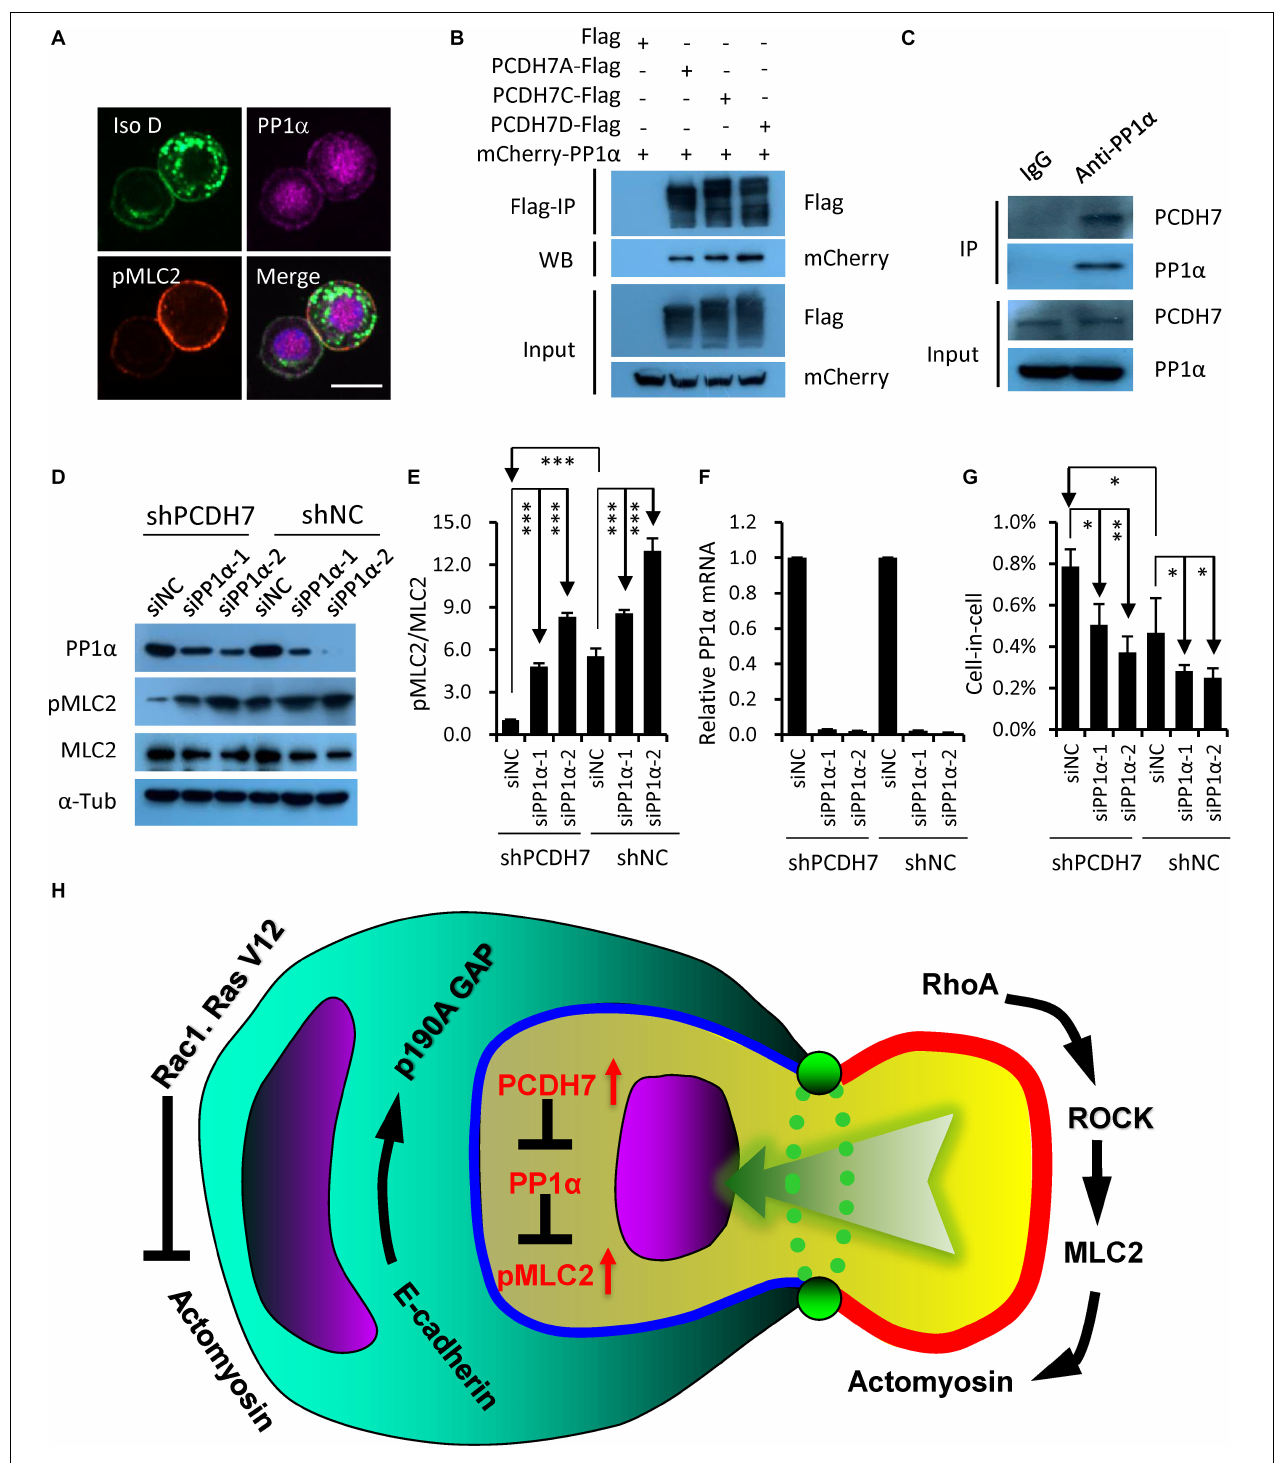
FIGURE 4 | PCDH7 interacts with PP1 α to inhibit homotypic cell-in-cell formation. (A) PCDH7 co-localizes with PP1 α at cell-cell contact. Scale bars: 15 µ m. (B,C) PP1 α interacts with PCDH7 as determined by co-immunoprecipitation assay in HEK293FT cells for overexpressed proteins (B) or MDA-MB-436-2 cells for endogenous proteins (C) . (D) Increased pMLC2 expression upon PP1 α knockdown as determined by Western blot in MDA-MB-436 cells. (E) Quantification of pMLC2/MLC2 in (D) . ∗∗∗ P < 0.001. (F) Relative mRNA level of PP1 α upon knockdown in MDA-MB-436 cells. Data are mean ± SD of triplicate experiments. (G) PP1 α knockdown inhibits CIC formation in MDA-MB-436 cells. Data are mean ± SD of triplicate experiments. ∗ P < 0.05; ∗∗ P < 0.01. (H) Updated working model for entotic CIC formation regulated by PCDH7 and PP1 α .